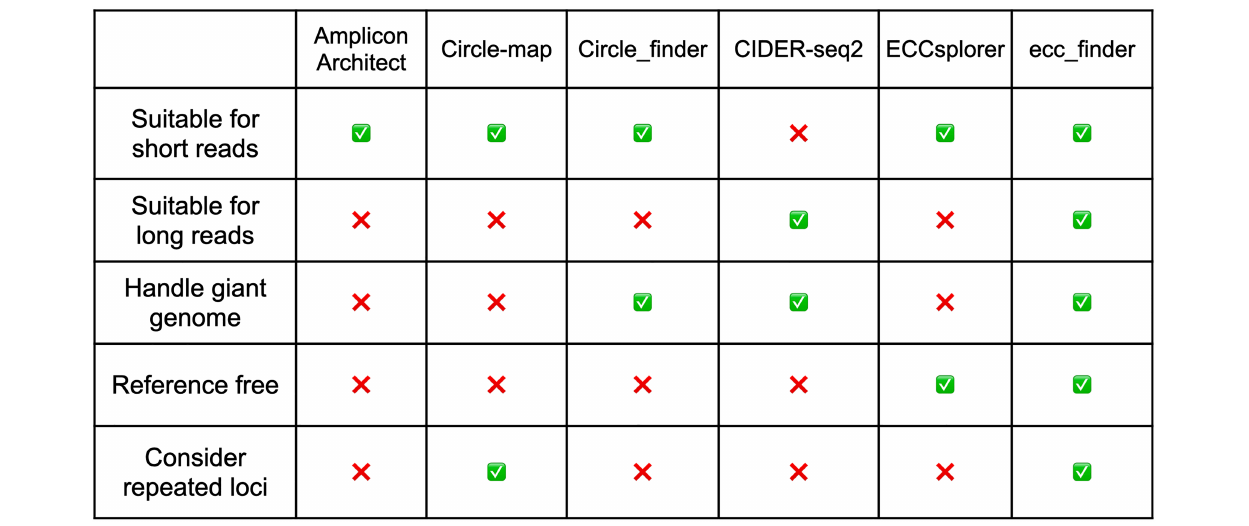
FIGURE 1 | Summary of the characteristics of up-to-date eccDNA detection